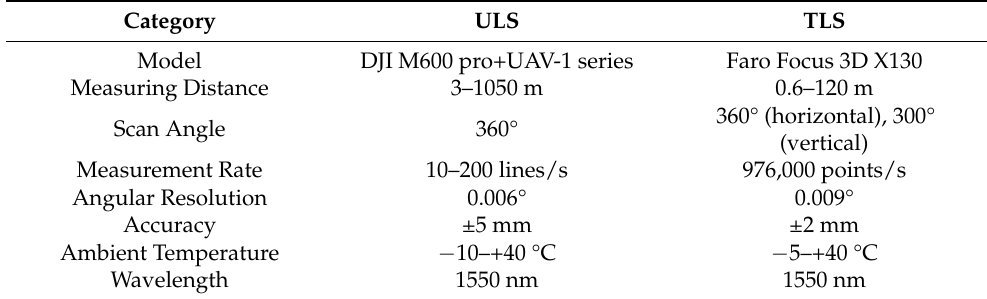
Table 1. Lidar system parameters. In the process of acquisition, various parameters of the Lidar system are taken into consideration.